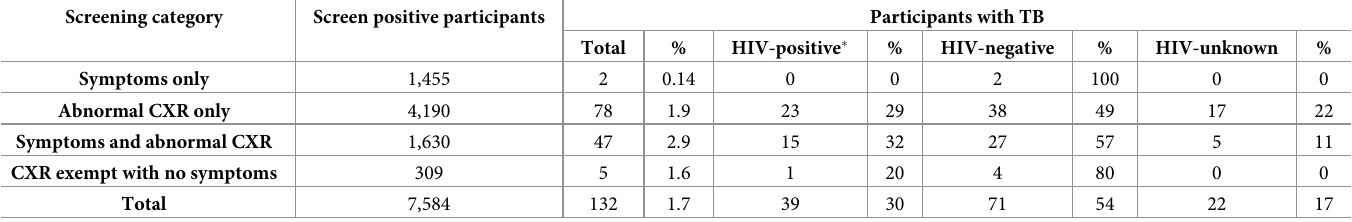
Table 3. Yield by screening category and HIV